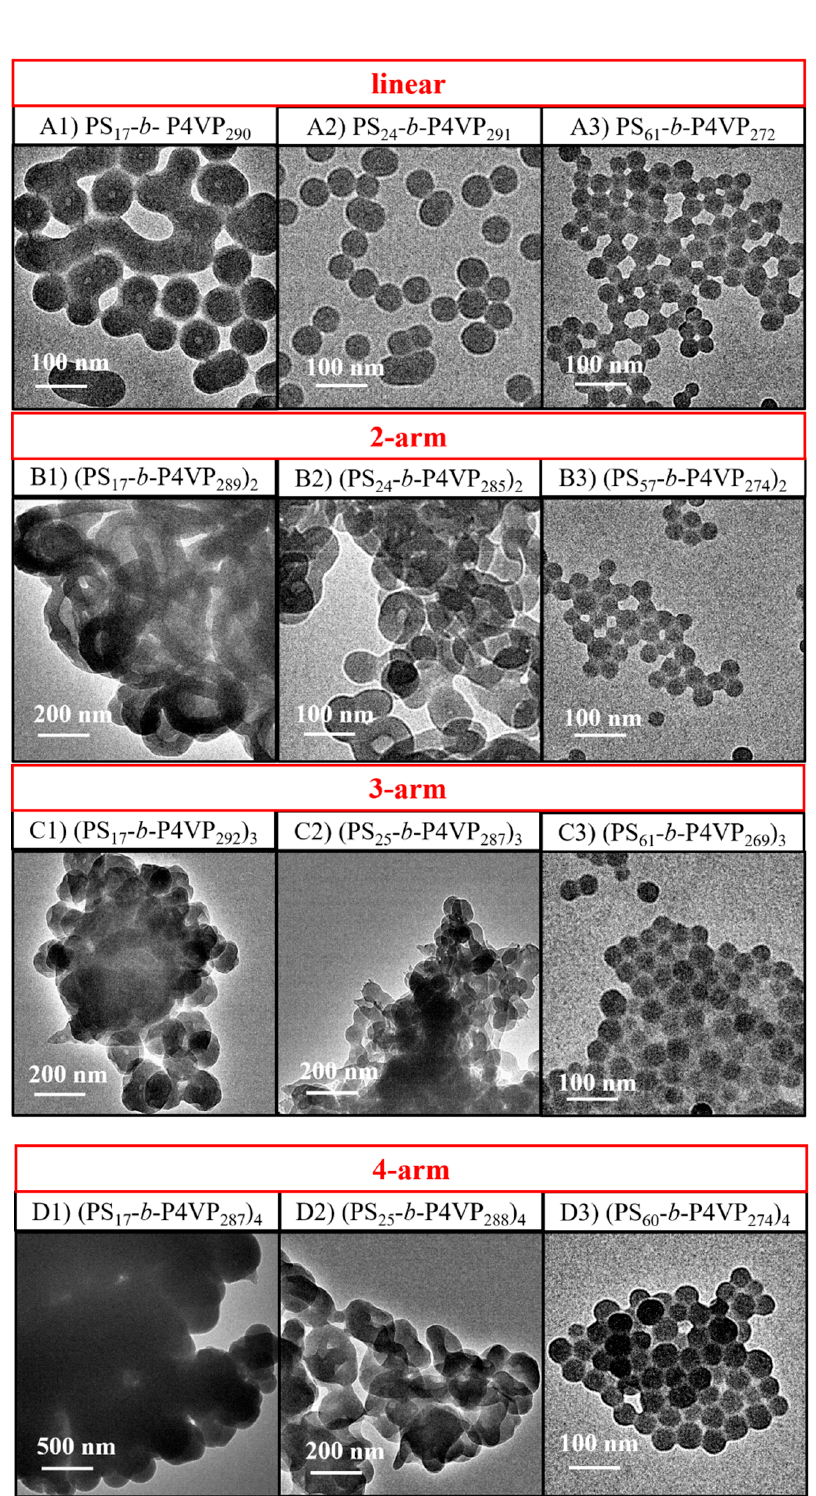
Figure 3. TEM images of (PS- b -P4VP) n nanoparticles containing similar P4VP segments but different PS segments. PS